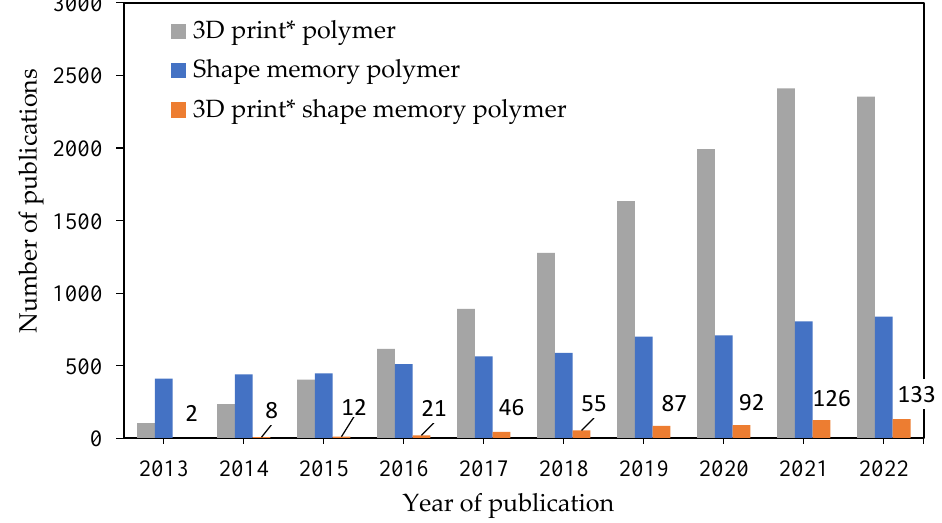
Figure 2. The number of publications related to 3DP of SMP since 2013 (data from Web of Science, 2022).